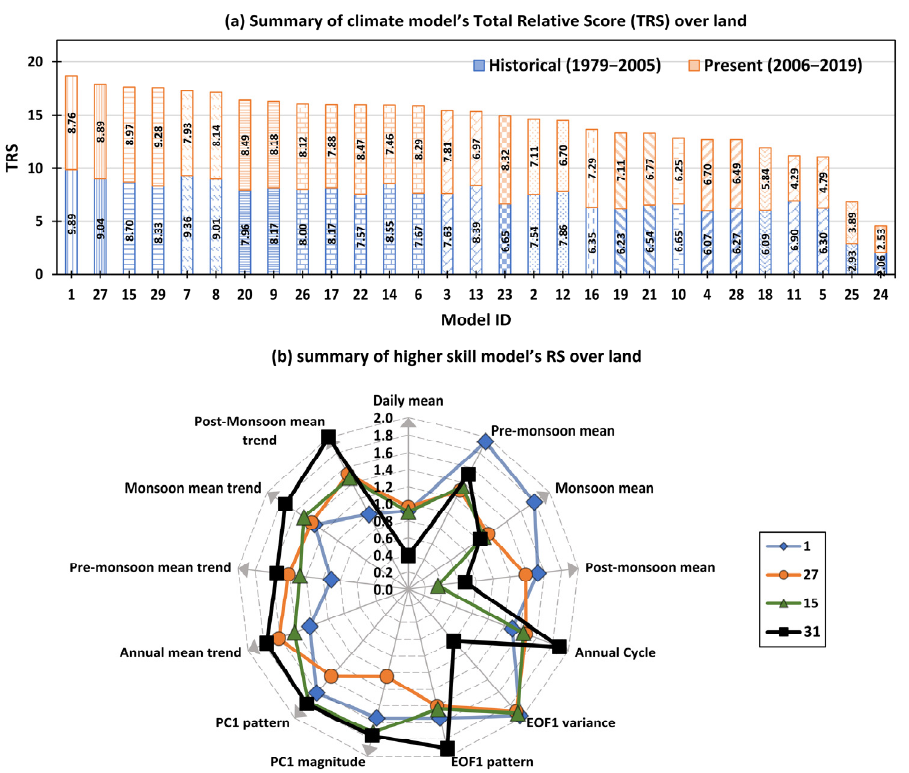
Figure 10. As in Figure 9, but the summary of climate model’s skill over land of the South Asian